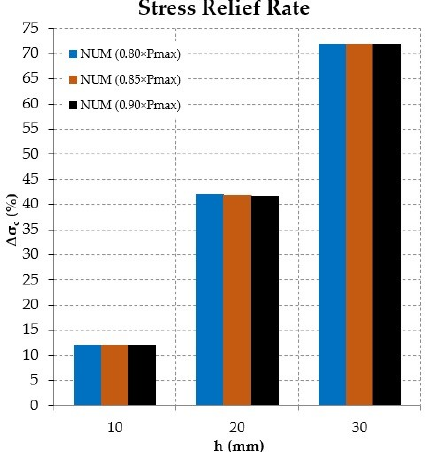
Figure 21. Stress relief rate for three depths of saw-cuts.